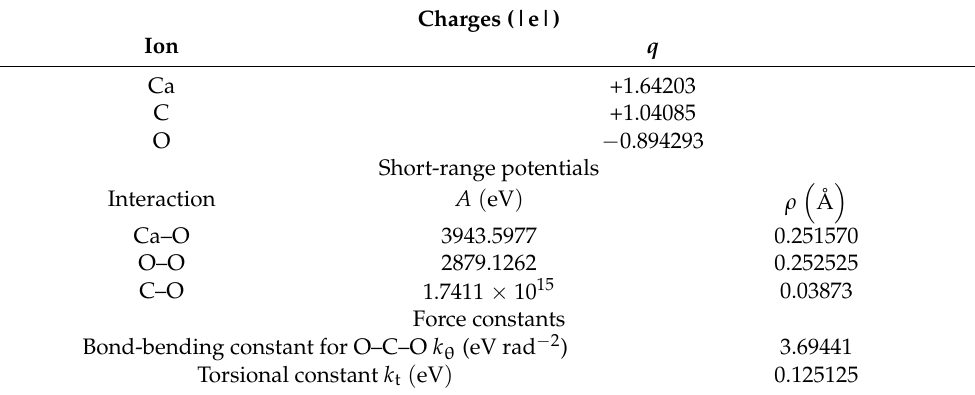
Table 1. Potential function parameters [34].